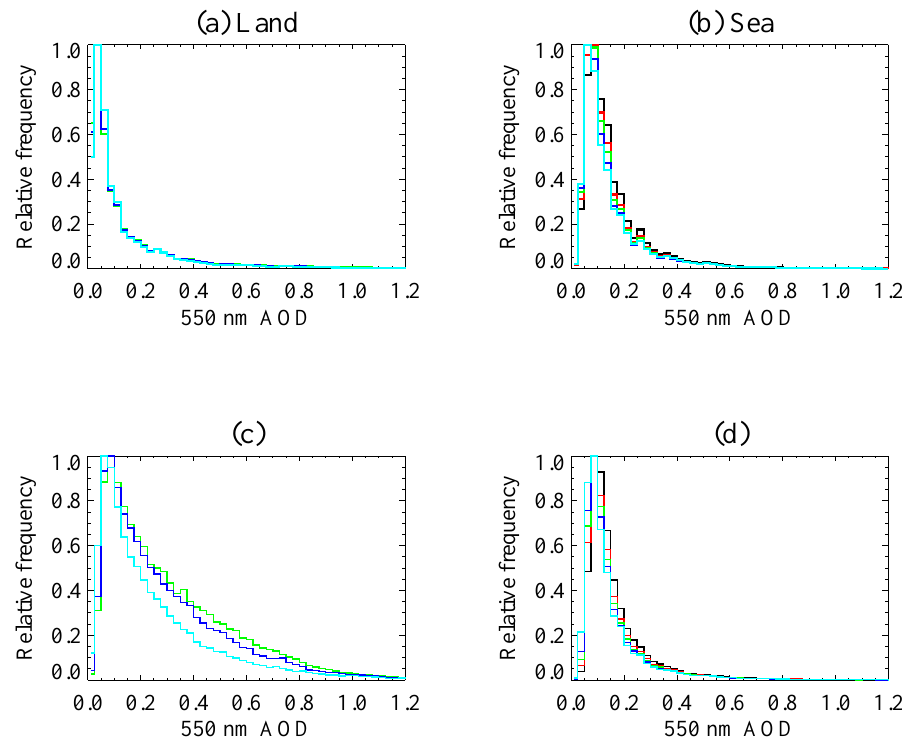
Fig. 4. Relative frequency histogram of GlobAerosol-AATSR iretrieved AOD for land (left) and sea (right). The coloured lines indicate different thresholds on the maximum (10km × 10km) retrieval pixel cloud fraction: black indicates no threshold, red at least 25% clear (1km × 1km instrumental) pixels, green at least 50% clear, dark blue at least 75% clear, and pale blue 100% clear. The top row (a, b) shows histograms created from individual retrievals, and the bottom (c, d) shows histograms from retrievals averaged to the GEOS-Chem grid. Only the last three lines are present in (a) and (c).